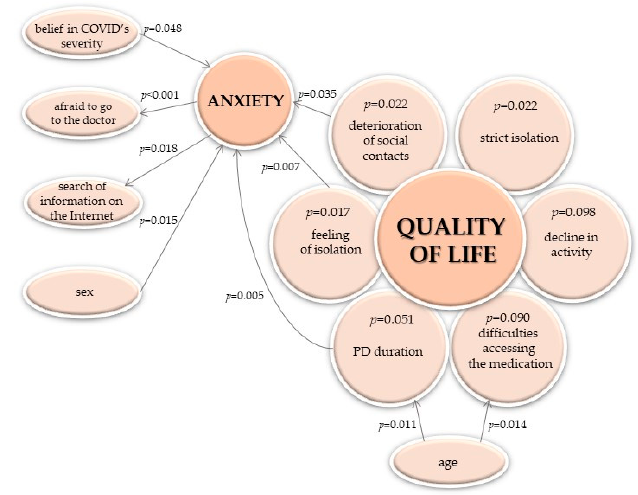
Figure 7. The chain of dependence between the change in the quality of life and other studied features. The presented p -values for quality of life refers to the frequency of its decline—results of the chi-square or the Fisher exact test, respectively (not to its change in points, per the Mann–Whitney test); the only exception is the association with activity